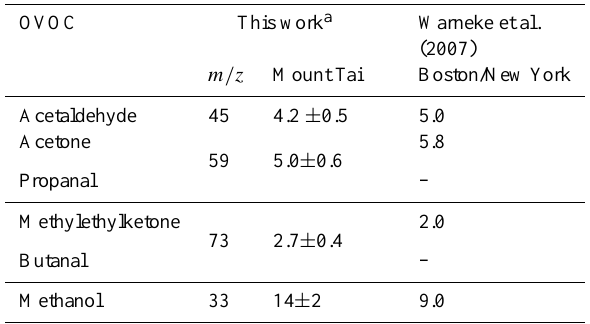
Table 6. 1 OVOCs/ 1 CO (pptv/ppbv) ratios without biomass burn- ing